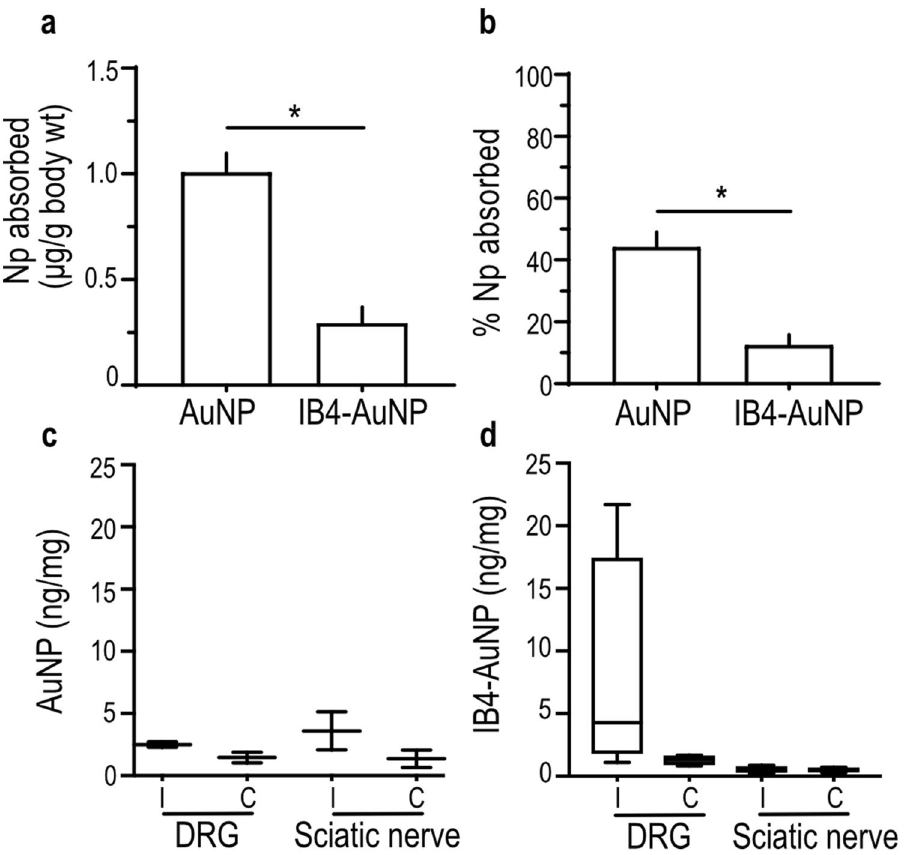
Figure 6. Topical application of IB4-AuNP to the rat hind paw. Bar graphs indicating the amount (a) and percent (b) of gold nanoparticles that penetrate across the rat hind-paw skin after topical application of non- functionalized AuNP or IB4-AuNP. Data shown are mean ± S.D., with n = 4 rats per group. * P < 0.05, Students t-test. Box-whisker plots indicating the amount of gold nanoparticles detected in DRG and sciatic nerve tissue harvested from rats that were topically treated with non-functionalized AuNP (c) , or IB4-AuNP (d) . Data shown are measurements obtained from n = 2–4 animal sets per group, with each set comprising of pooled tissue from 4 rats. (i = ipsilateral; c =